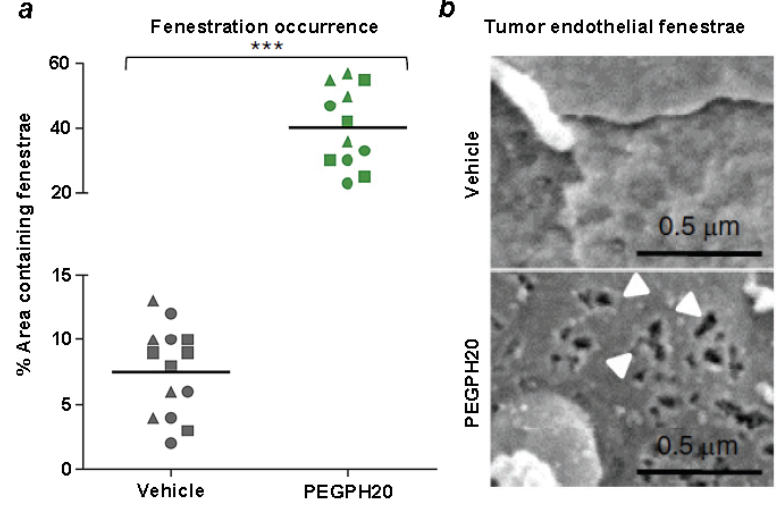
Figure 8. Induction of endothelial fenestrae as a result of treatment with PEGPH20. ( a ) The frequency of vascular fenestrae in KPC tumors was estimated using scanning electron microscopy and quantified in 4 random vessels in 3 mice per cohort; ( b ) Visualization of fenestrae from vehicle-treated and PEGPH20-treated KPC mice with PDA by scanning electron microscopy (n = 4 for each cohort). Fenestrations were found in pancreatic blood vessels of PEGPH20-treated tumors. PEGPH20 did not induce formation of fenestrae in normal pancreatic blood vessels of the control (PC) mouse.